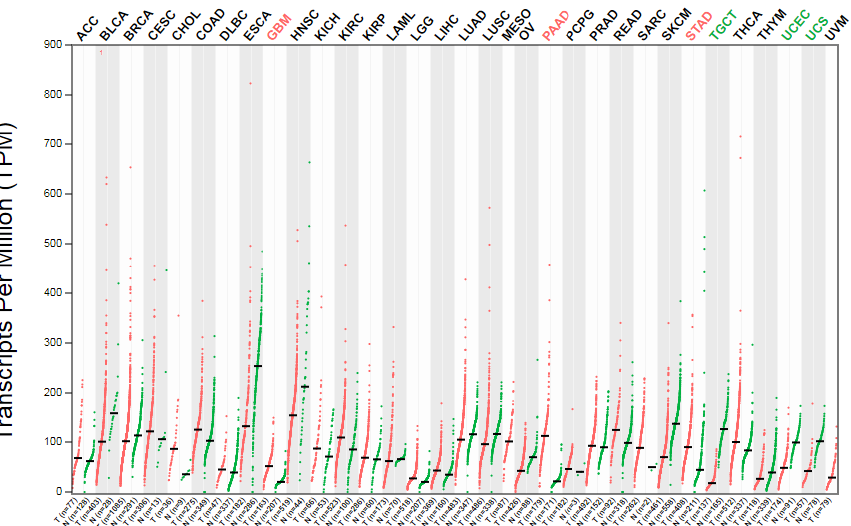
Figure 2. Bodymap indicating CAST expression; red for tumor and green for normal. Statistically significant in GBM, PAAD, STAD, TGCT, UCEC, and UCS.